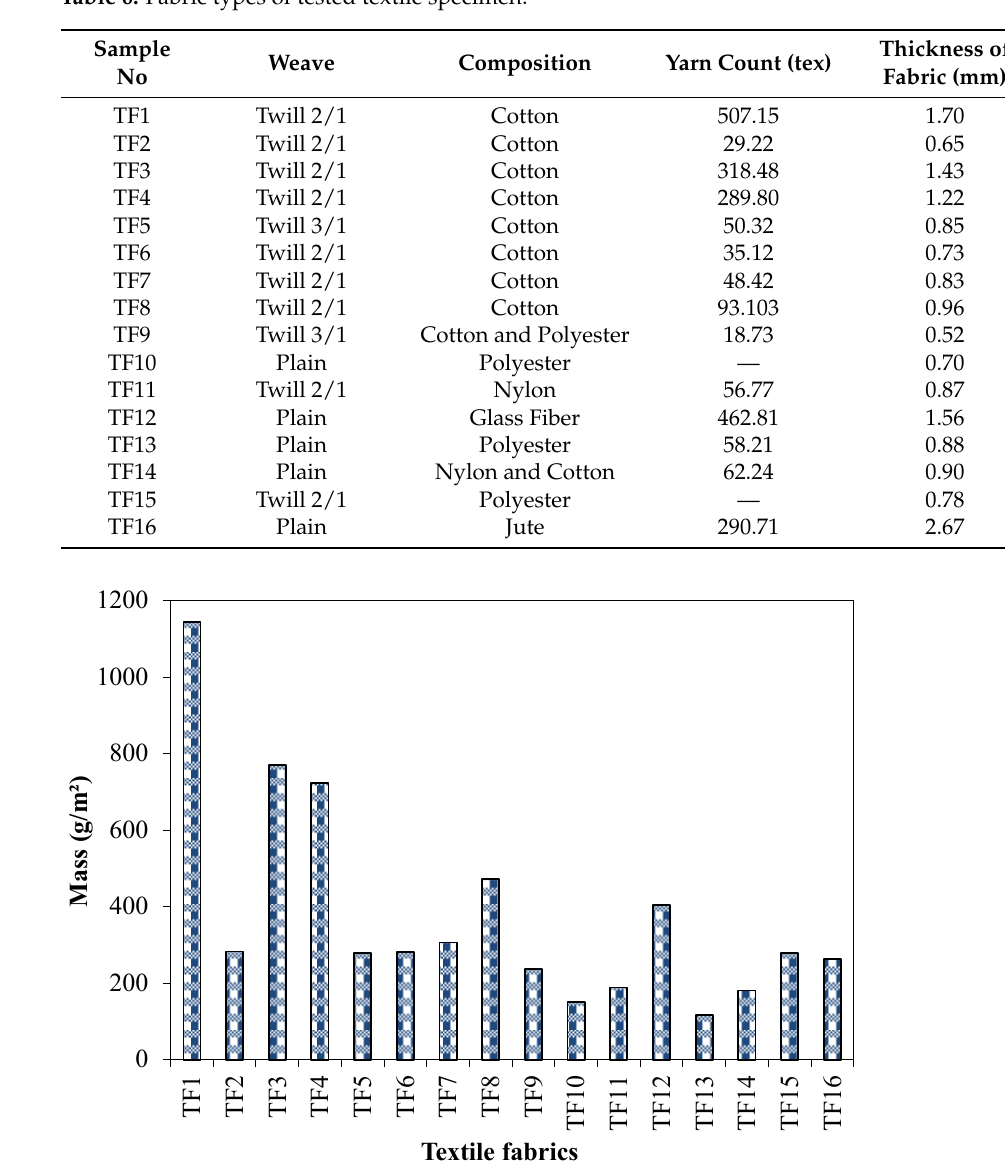
Figure 9. Mass per unit area results of tested textile fabrics.